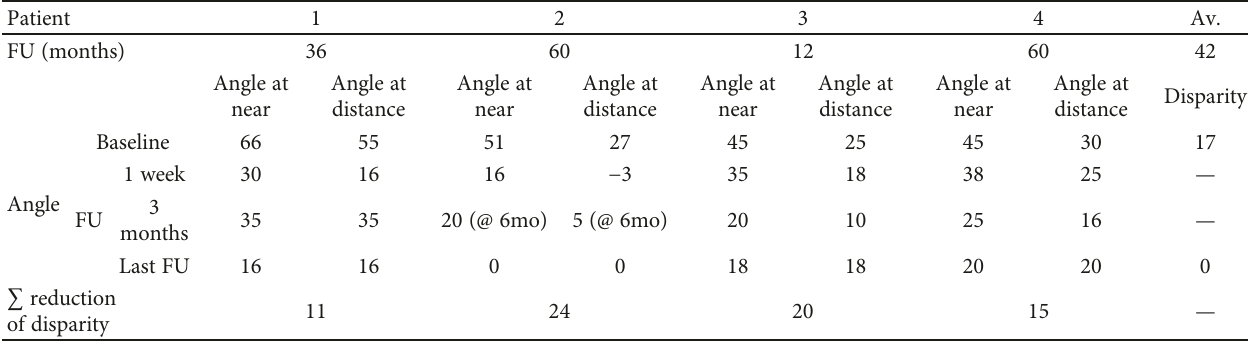
Table 2: Strabismus angles in prism